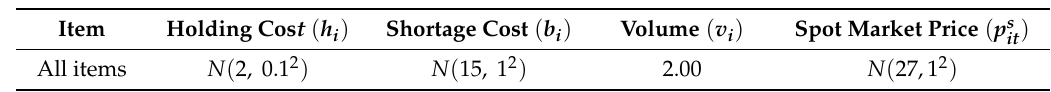
Table 3. Input parameters for each item.